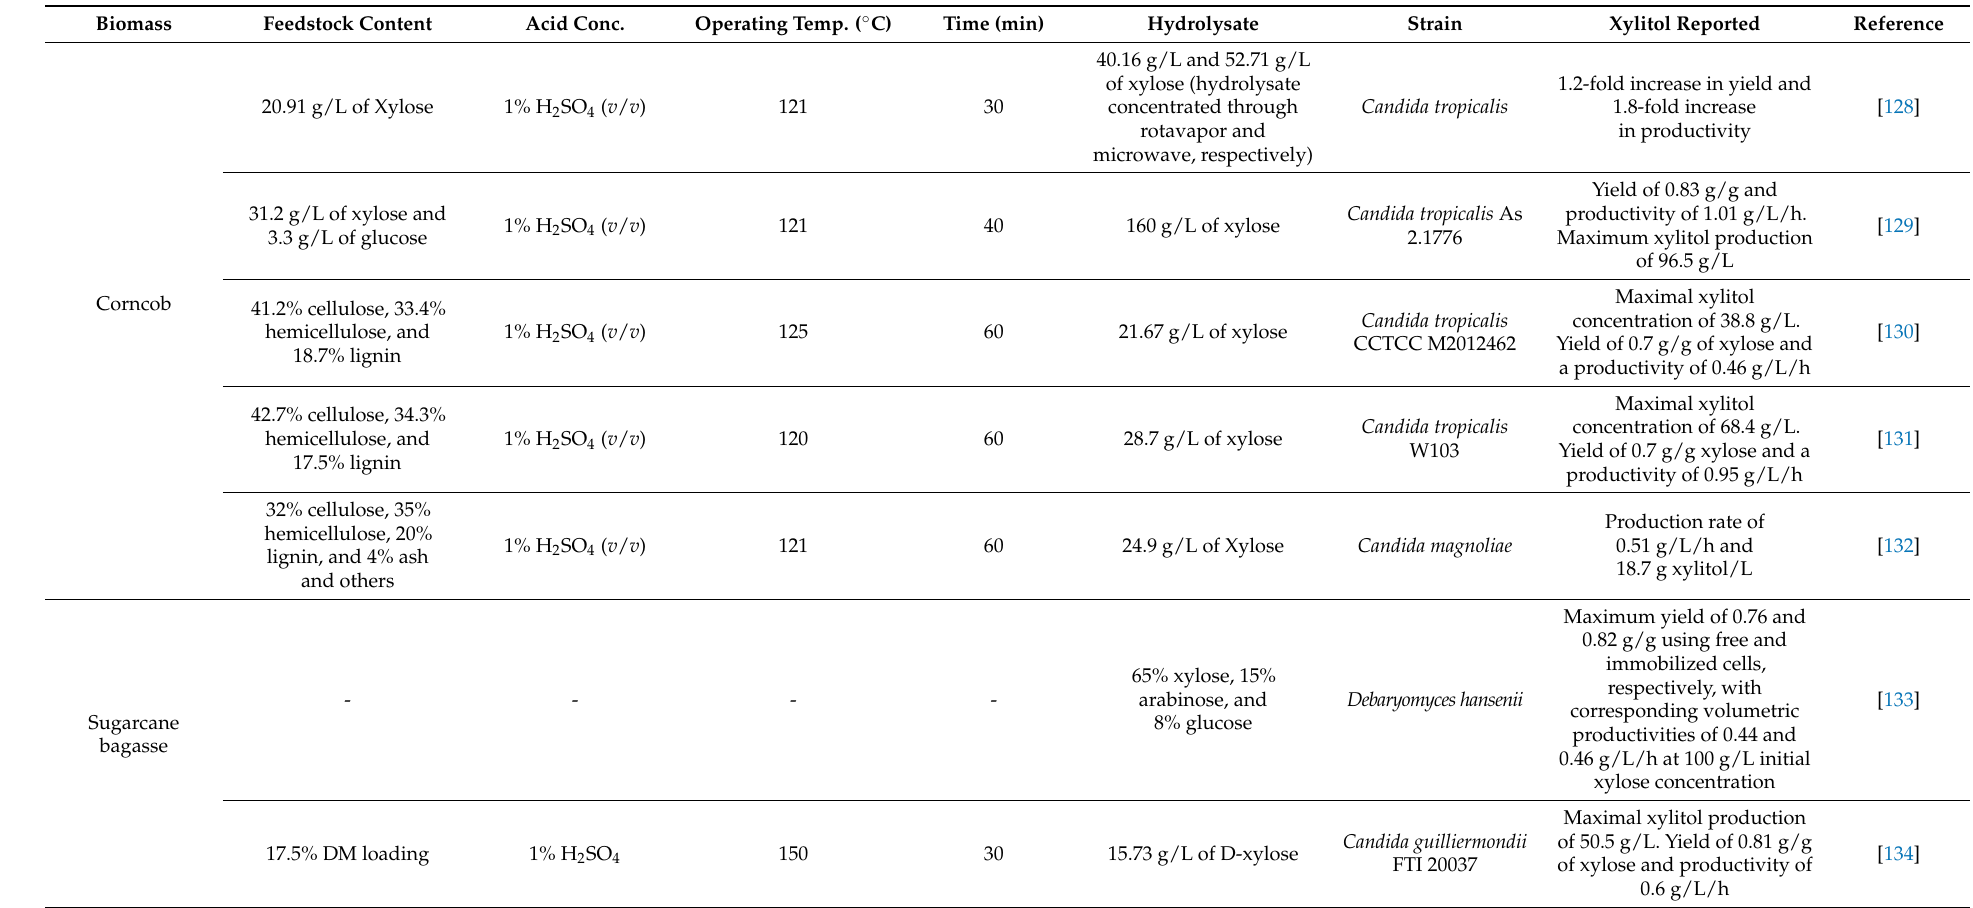
Table 6. Review of extraction methods for xylitol from lignocellulosic